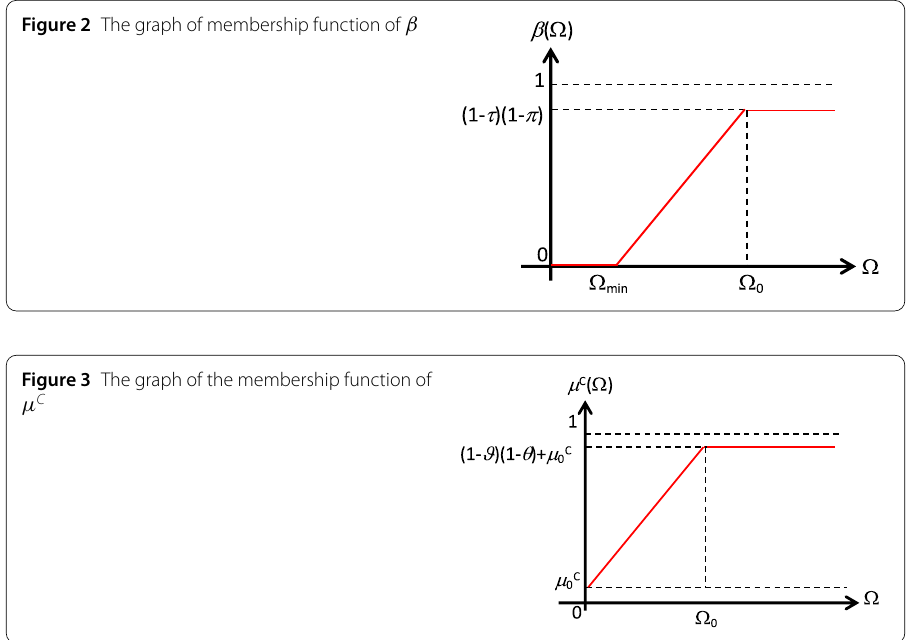
Figure 3 The graph of the membership function of μ